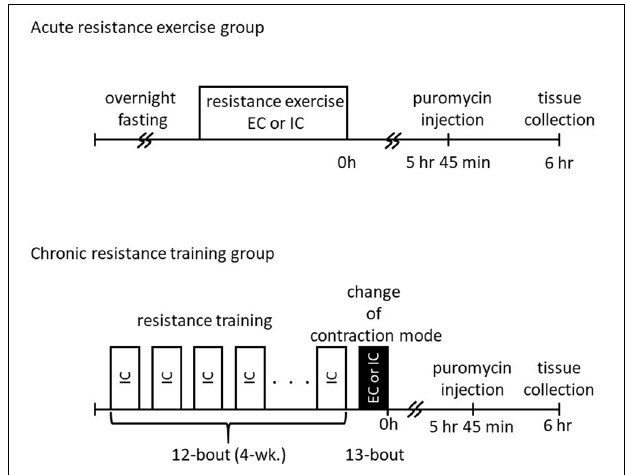
FIGURE 1 | Schematic overview of study